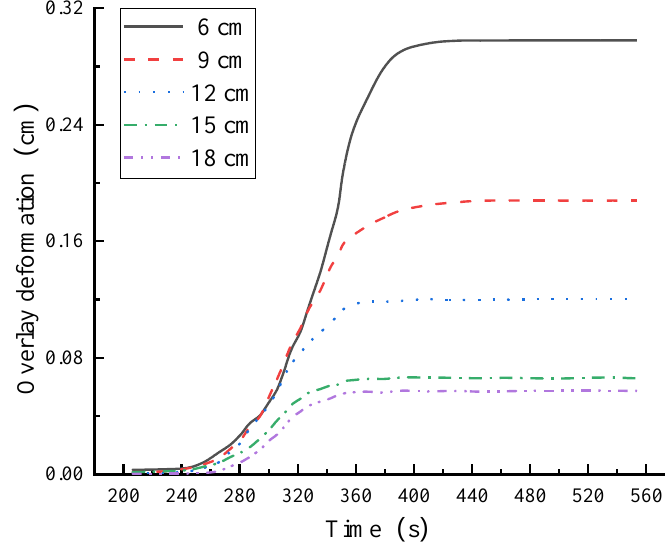
Figure 7. .Rising water table cover settlement.